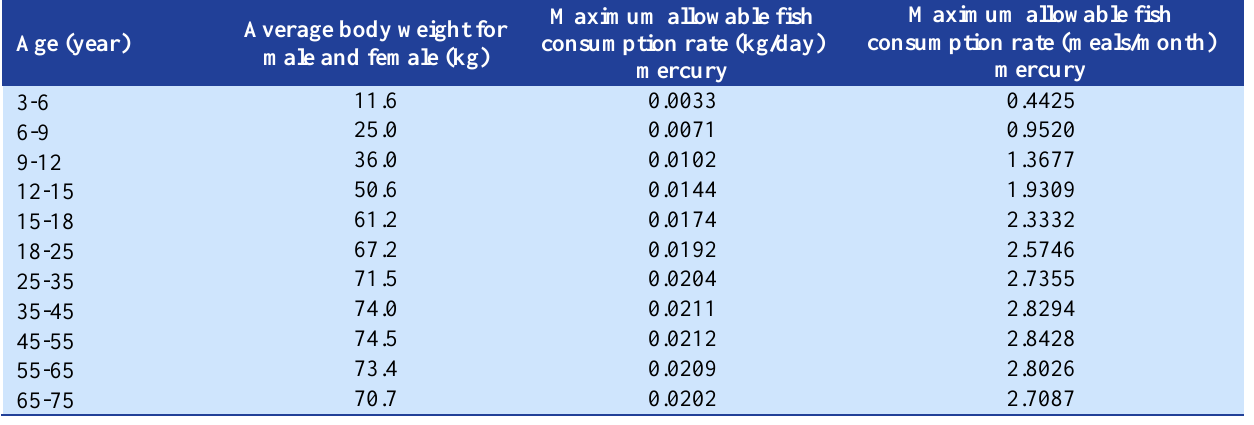
Table 2. Maximum allowable fish consumption rate according to the metals content Age